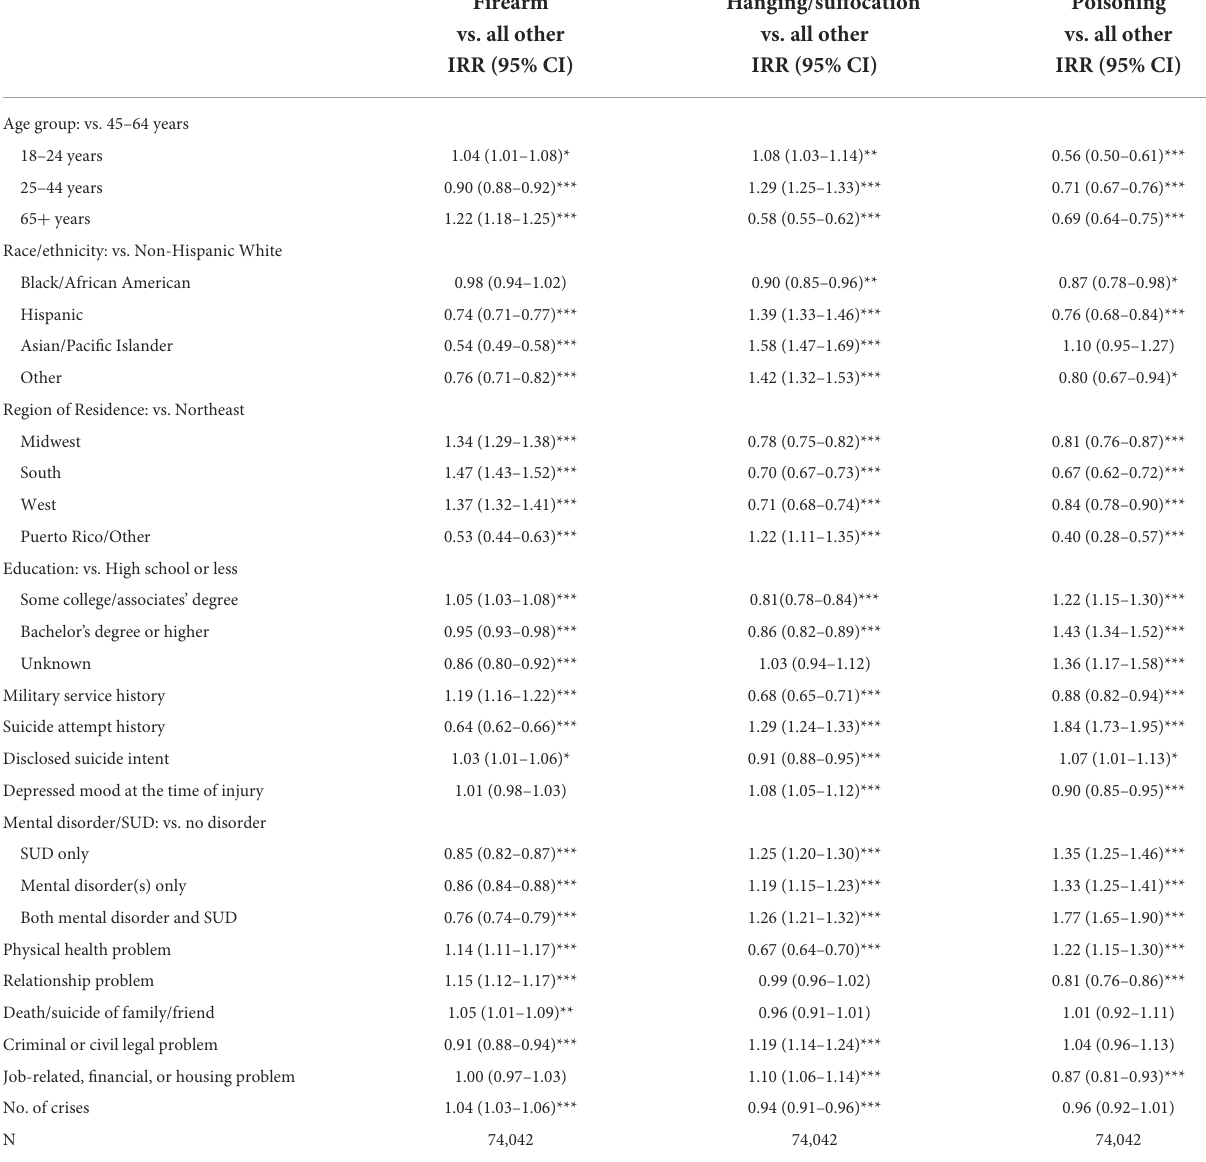
TABLE 4 Correlates of firearm, hanging/suffocation, and poisoning use among men: Results from generalized linear modeling for a Poisson distribution with a log link.